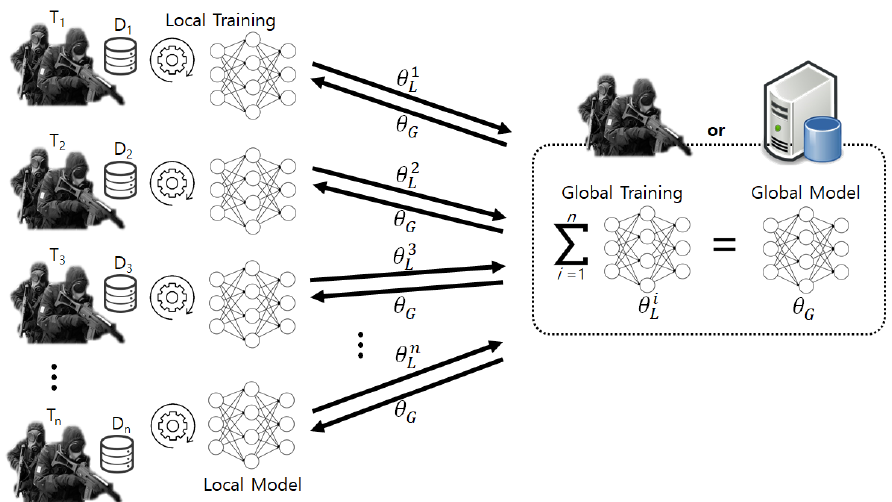
Figure 6. The overall operations of FL in the proposed